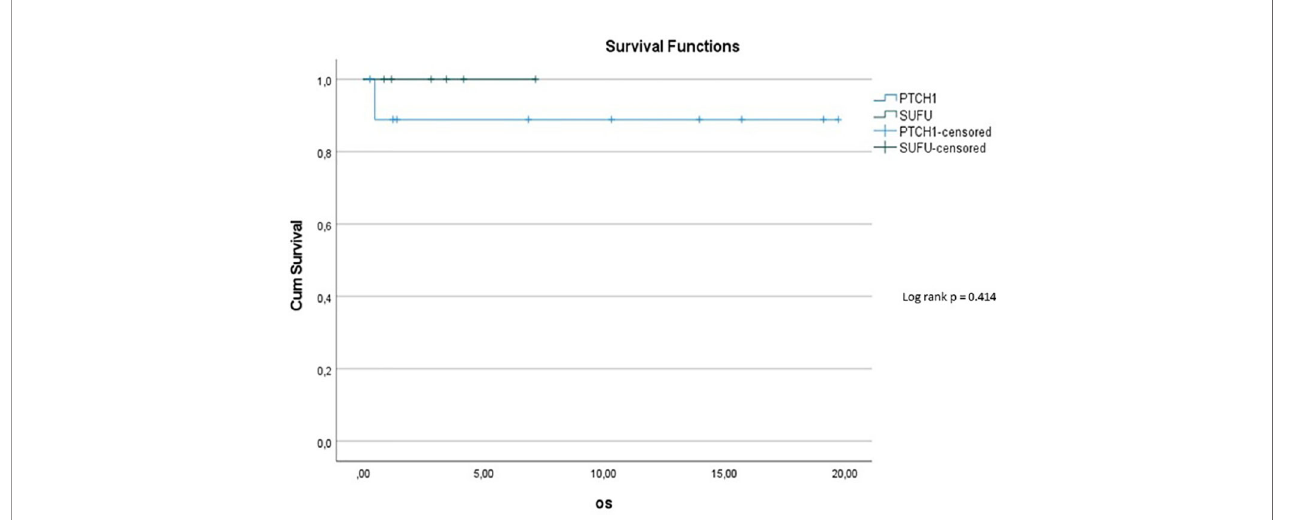
FIGURE 5 | Kaplan-Meier plot for OS for patients depending on mutational status (blue = PTCH1 mutated patients; green = SUFU mutated patients).